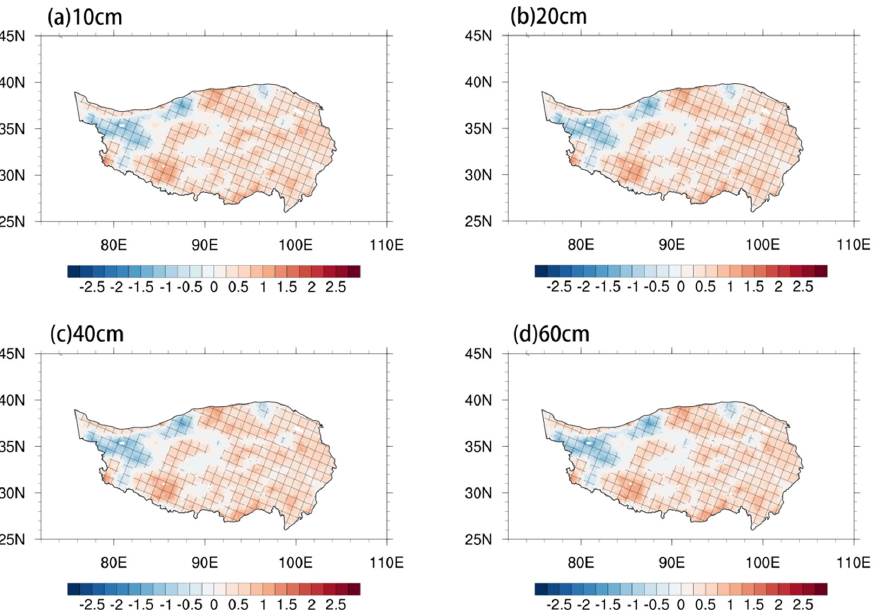
Figure 5. Trends in soil temperature at four different soil depths across the TP from 1980 to 2016 (unit: °C/decade). ( a ) 10 cm; ( b ) 20 cm; ( c ) 40 cm; ( d ) 60 cm.